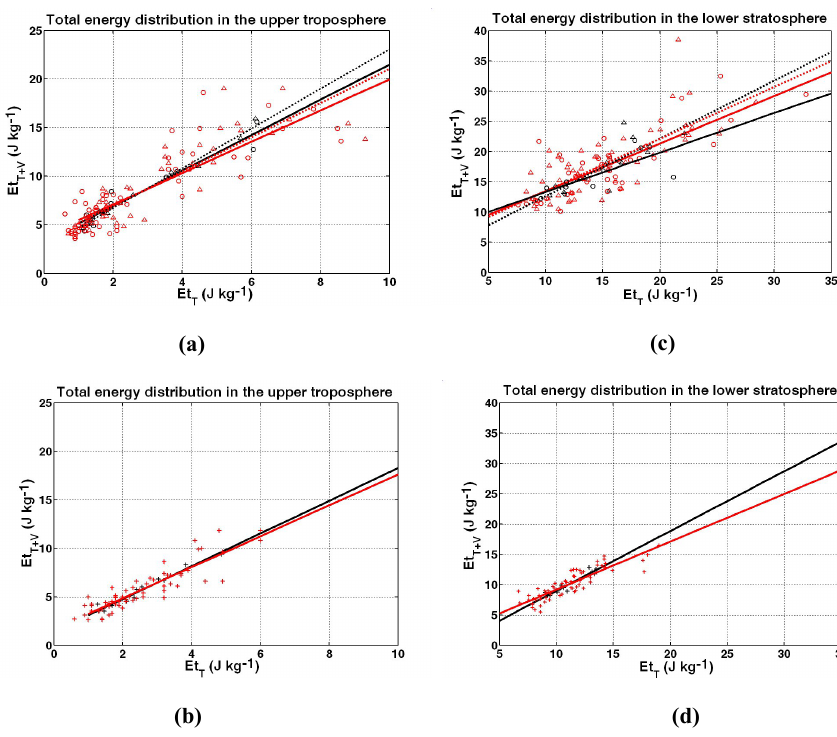
Figure 2. Monthly and monthly-mean wave energy density derived from temperature and wind (Et T + V ) versus those derived from temperature only (Et T ) (a) above Mahé at 0000 UT (red and black circles respectively) and at 1200 UT (red and black triangles) and corresponding least-squares regression lines for Mahé at 0000 UT (red and black dashdot lines respectively) and 1200 UT (red and black solid lines respectively) and (b) above Tromelin at 1200 UT (red and black crosses respectively) and corresponding least-squares regression lines (red and black solid lines respectively) in the UT. (c) and (d) Same as Fig. 2a and Fig. 2b respectively but for the LS.